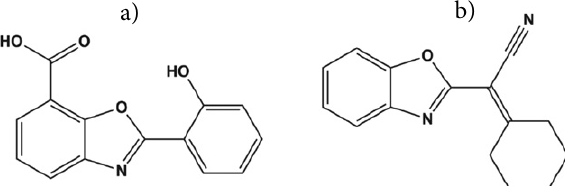
Figure 1. Structure of Caboxamycin (a) and (b) a synthetic deriva- tive of benzoxazole.